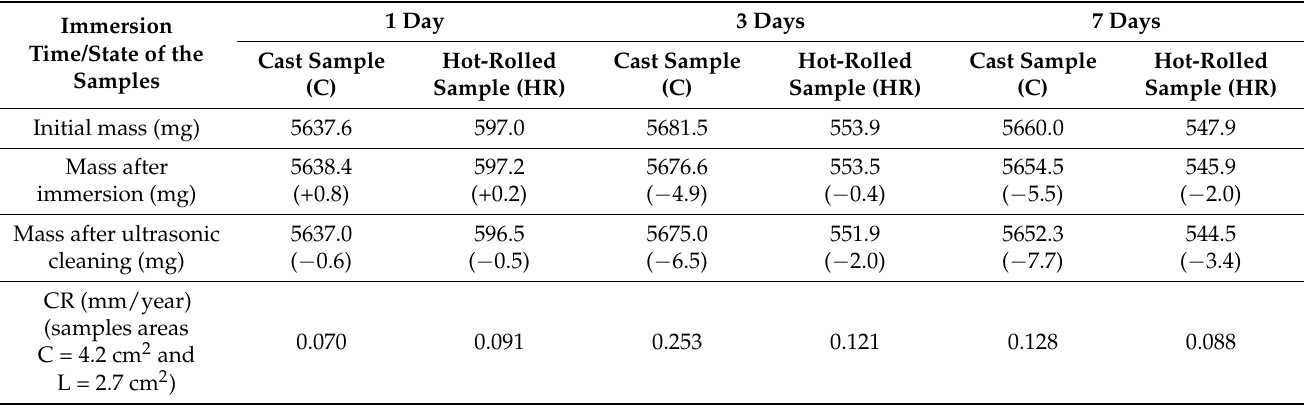
Table 4. CR determined by each mass gain/loss of the samples subjected to immersion tests and subsequent cleaning in the ultrasonic bath (immersion time for 1, 3, and 7 days; lots of three samples for each immersion period were used and labeled the average